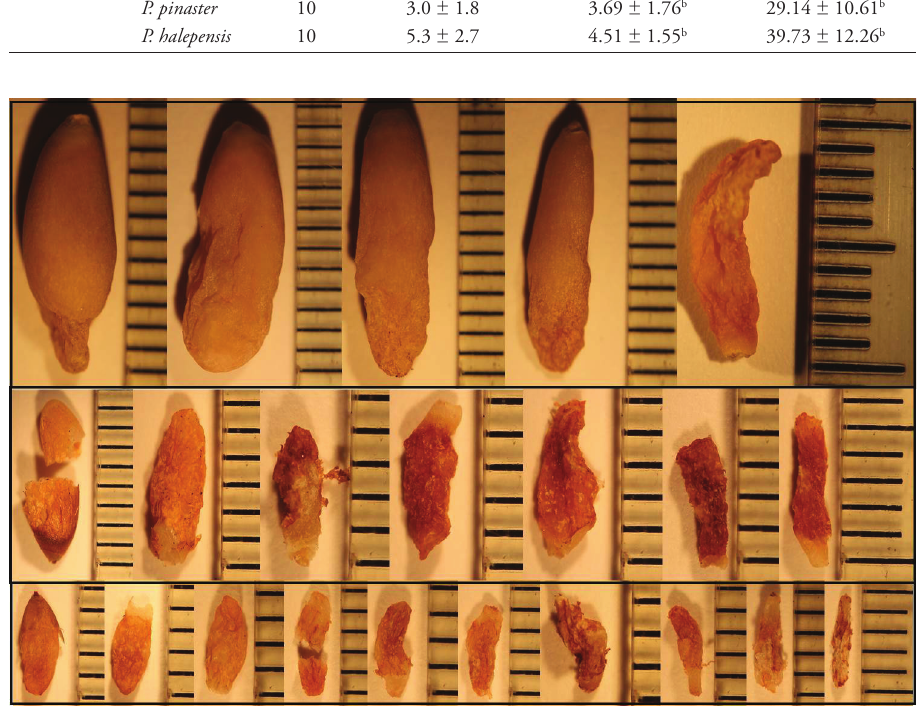
Figure 2. Seed three-choice trial. A sample of seeds consumed by L. occidentalis on the three-choice trial. Each row corresponds to a different host pine: (from top to bottom) P. pinea , P. pinaster and P. halepensis , with seeds arranged in each row from the less (left) to the more damaged (right). Photographs taken by Canon 1100 D. The marks on the scale correspond to 1mm. (Photos were taken by Charlene Durpoix).